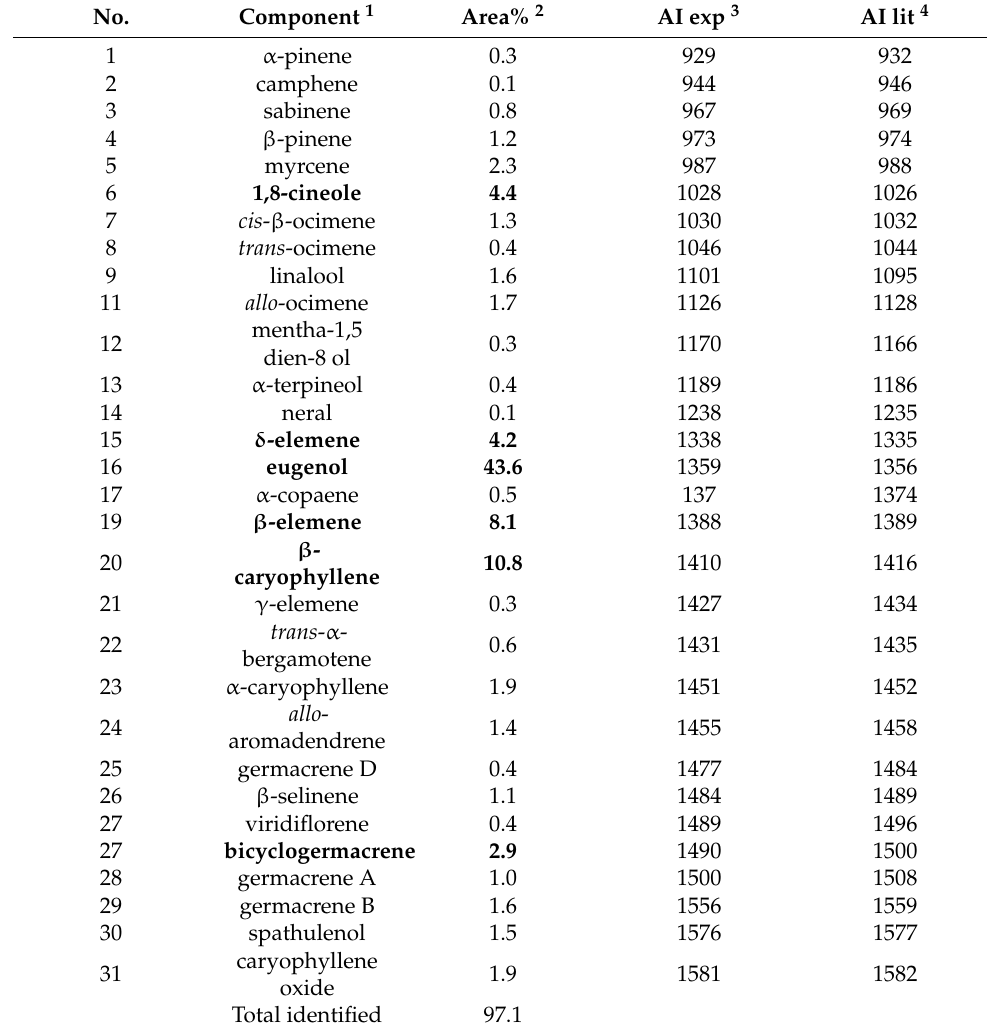
Table 1. Essential oil composition of O.